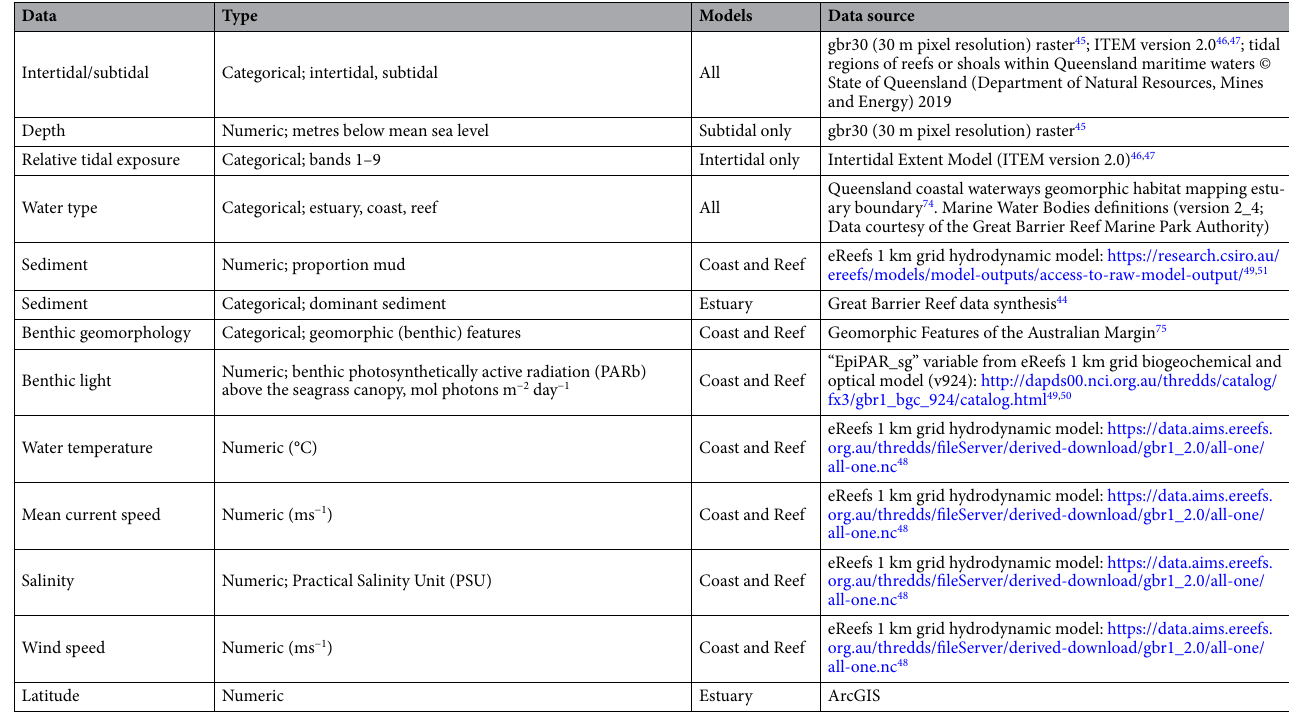
Table 4. Spatial data used to quantify environmental conditions and determine model boundaries. More details are provided in ESM Appendices S3 and S4.